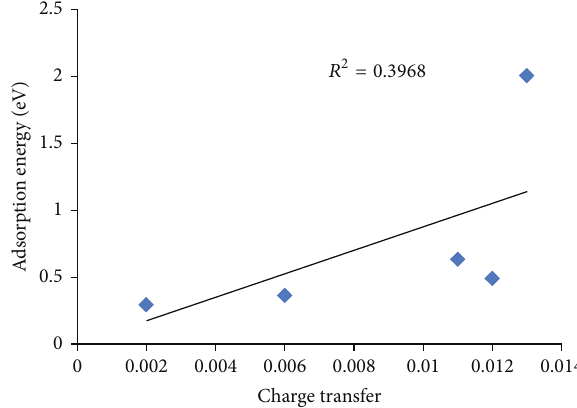
Figure 7: Weak linear correlation between the charge transfer parameter and adsorption